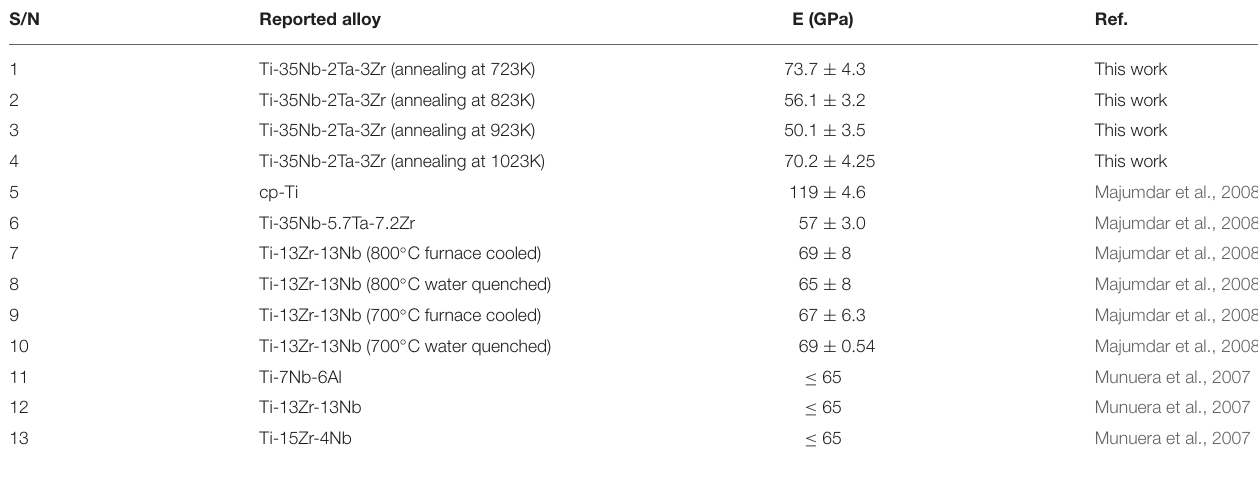
TABLE 1 | Elastic modulus of typical biomaterial alloy tested by nano-indentation. S/N Reported alloy E